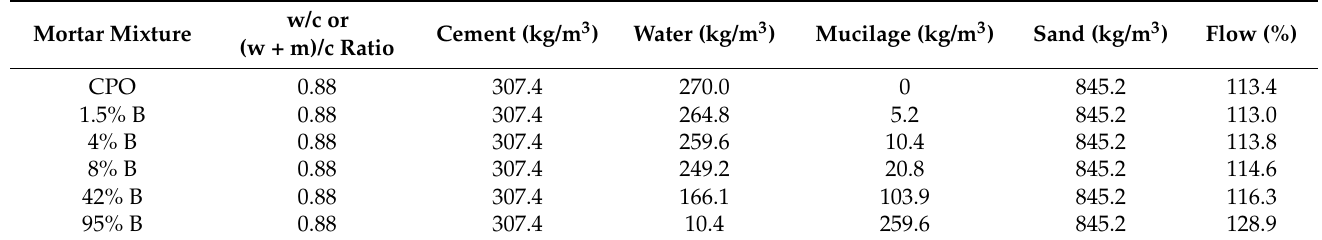
Table 1. Mixture proportions and mortar flow values for each mixture tested